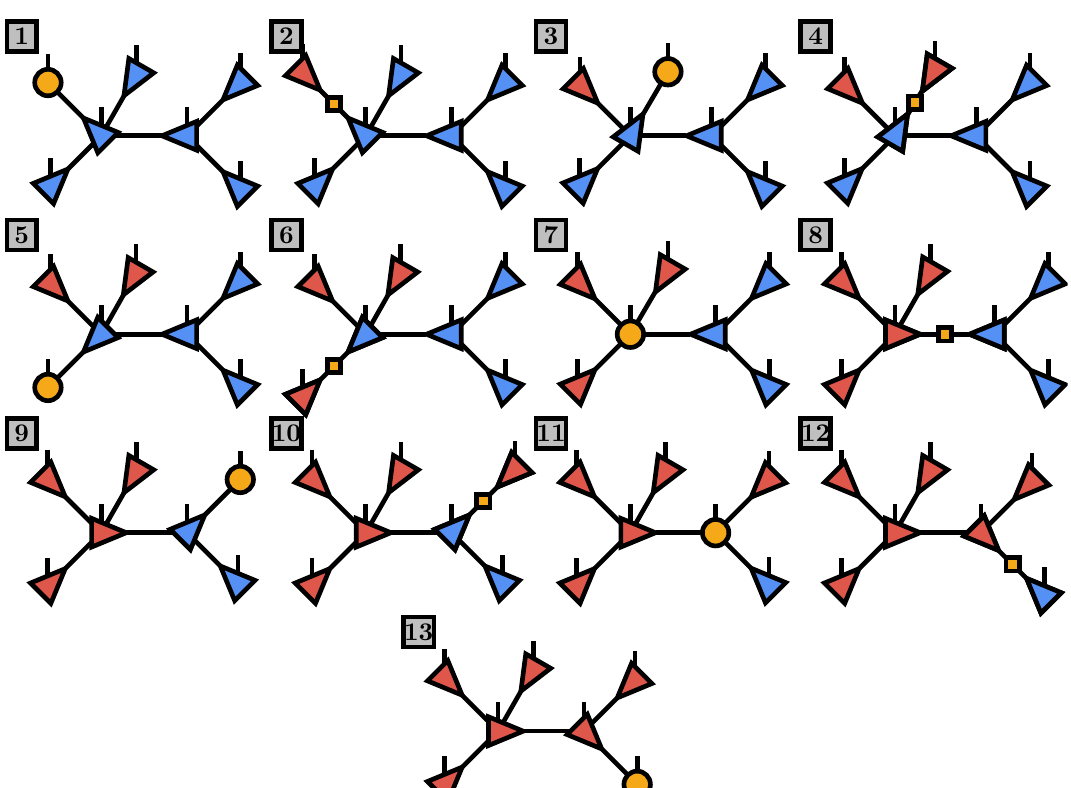
Figure 7: Update sequence to perform a first-order single-site TDVP time step from time t to t + ∆ t for the TTN shown in Fig. 1. Start point is site 1 and end point site 7. Yellow denotes tensor that are updated in the current step. Red and blue tensors in- dicate whether this tensor is taken at time t + ∆ t (red) or t (blue). Triangles indicate the orthogonalization of each tensor. Updates on site-tensors are in forward direc- tion (negative sign), while updates on bond-tensors are backwards time evolutions (positive sign in Eq 17). For a second order update, first perform all steps ( 1 ) → ( 13 ) with time step dt in the order shown and then reapply them in the reverse order 2 ( 13 ) → ( 1 ) , again with time step dt 2